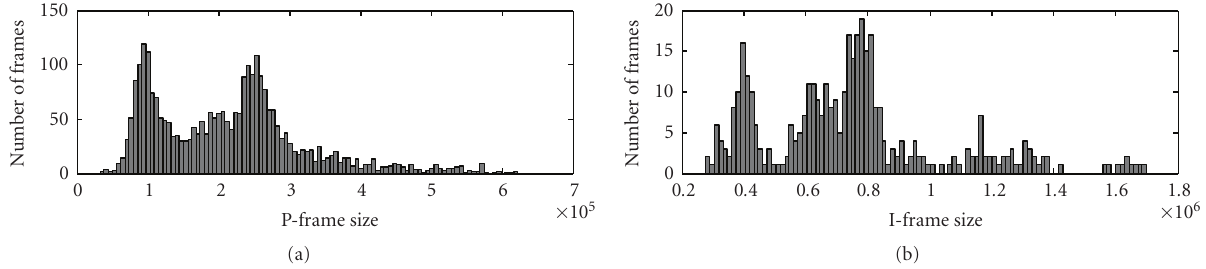
Figure 6: Histograms of P and I frame size in “The Living Sea” video sequence encoded with a constant QP.